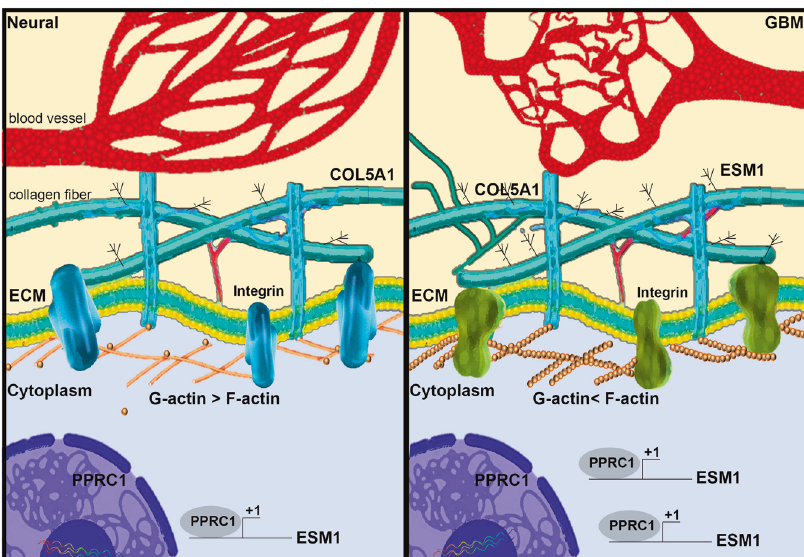
Fig. 7 Schematic model of the COL5A1 − PPRC1 − ESM1 axis in GBM tumorigenesis. COL5A1 can reprogram the cytoskeleton composition, thereby upregulating the ratio of F-actin, and promoting PPRC1-ESM1 axis to accelerate cell migration, and